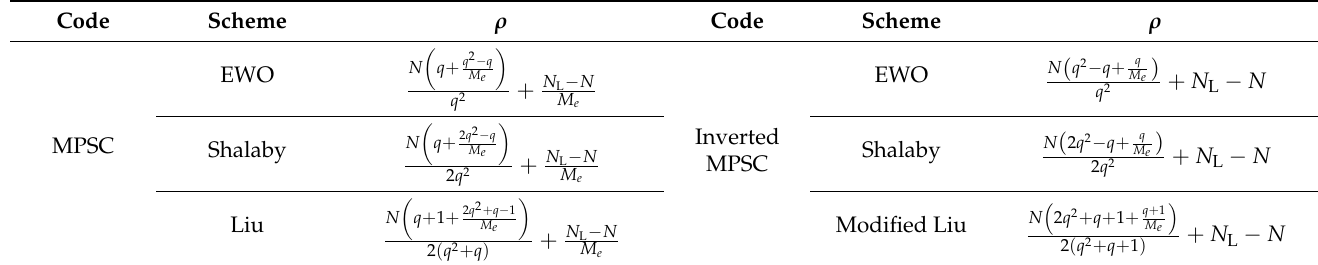
Table 5. The average light intensity ρ for the MUI cancellation